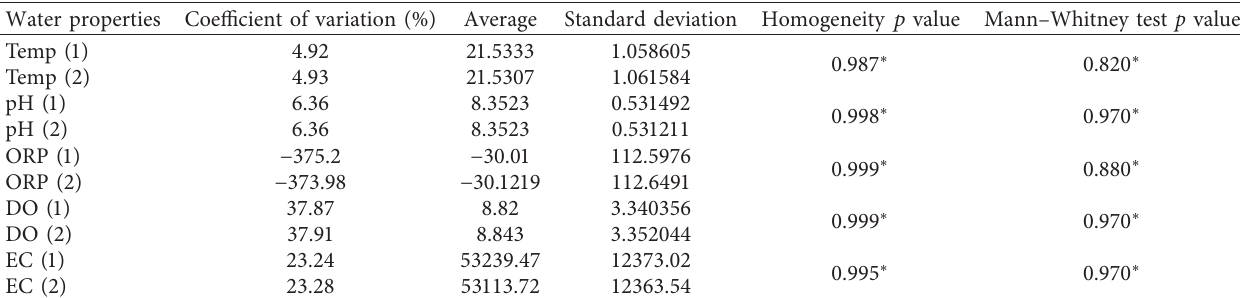
Table 5: Comparison between the values of estimated water elements and their actual data